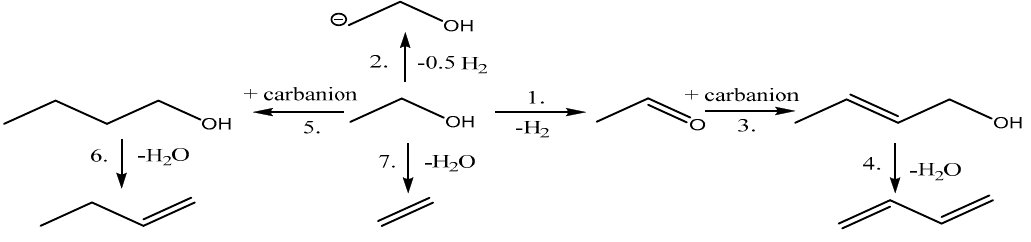
Figure 4. Novel reaction pathway for the formation of butadiene from ethanol proposed by Cavani et al.